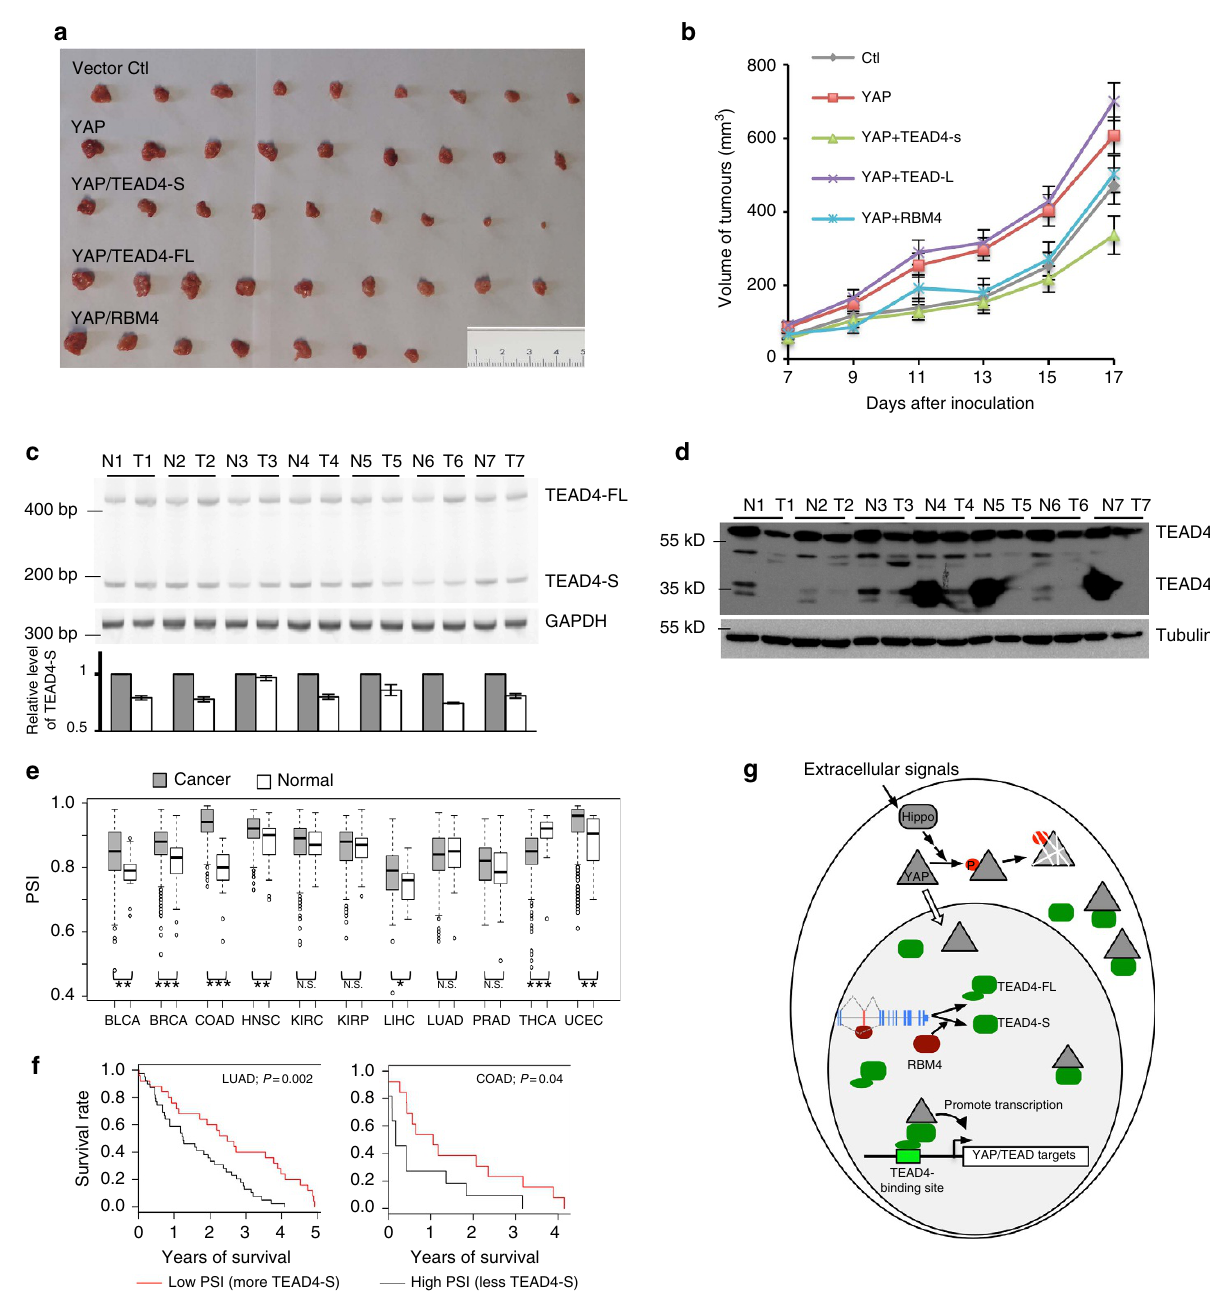
Figure 5 | TEAD4-S can inhibit tumour growth in vivo . ( a ) H157 cells stably expressing YAP, YAP/TEAD4-FL, YAP/TEAD4-S, YAP/RBM4 or vector control were subcutaneously injected into the flank of nude mice. Each group contained nine mice. Pictures of the tumours removed after 17 days were shown. Scale bar, 1cm. ( b ) The growth of xenograft tumours was monitored and the average sizes of xenograft tumours were measured every 2 days ( n ¼ 9, error bars indicate ± s.d., P o 0.05 by t -test). ( c ) Total RNA isolated from seven paired NSCLC tumours and adjacent normal tissues were assayed by semi- quantitative RT–PCR. The mean ± s.d. from three experiments was plotted. ( d ) TEAD4 levels from seven paired NSCLC tumours and adjacent normal tissues were analysed by western blot. ( e ) The splicing alteration of TEAD4 was examined in various cancers by analysing the TCGA consortium containing RNA-seq data sets from thousands of patients. The PSI of TEAD4 in the cancer or normal samples are presented as standard box plot, with the boxes presenting the first and third quartiles and the whiskers representing the 2nd and 98th percentiles. *** P o 0.0005; ** P o 0.005; * P o 0.05; and NS, not significant. ( f ) The overall survivals of lung cancer and colon cancer patients with different ratios of TEAD4 splicing isoforms were analysed. ( g ) The model of how the Hippo–YAP pathway is regulated through a TEAD4 splicing